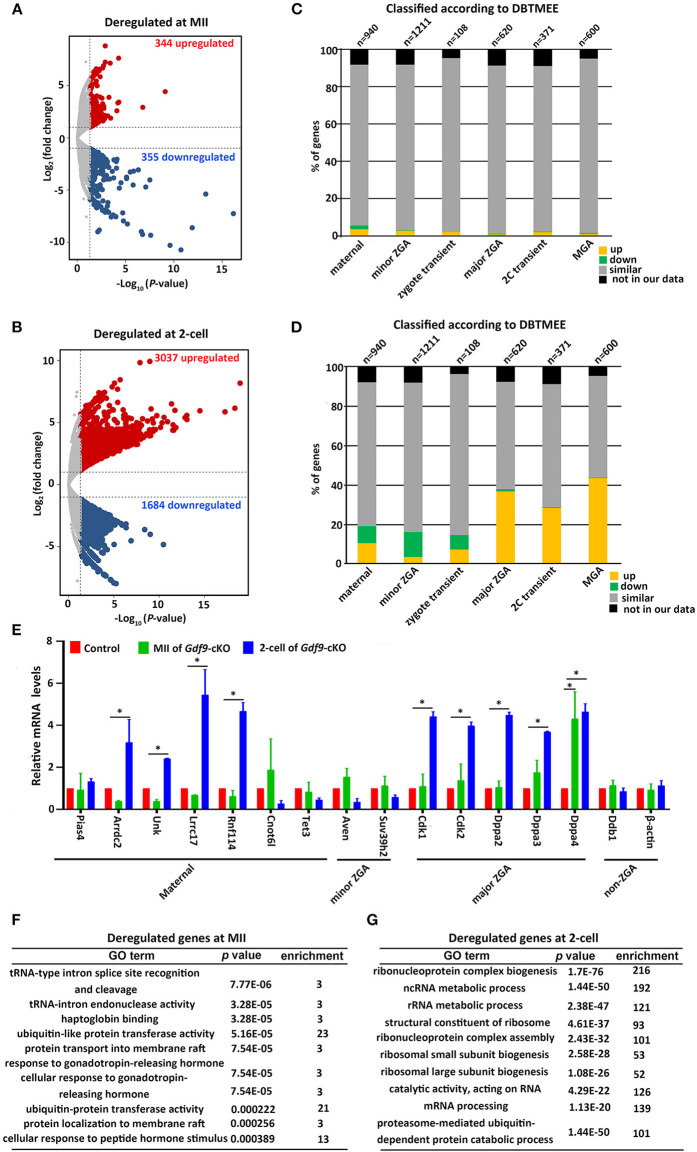
Abnormal ZGA upon absence of maternal UHRF1 revealed by transcriptome analysis. (A,B) Volcano plots showing the RNA-seq data obtained from (A) MII oocytes and (B) two-cell embryos of control and Gdf9-cKO mice. Red and dark blue dots indicate genes that were significantly upregulated and downregulated, respectively (fold change > 2, and FDR < 0.05) in Gdf9-cKO oocytes or embryos. (C,D) RNA-seq data from (C) MII oocytes or (D) two-cell embryos in comparison with the different categories of the gene catalog available at the Database of Transcriptome in Mouse Early Embryos (DBTMEE) generated the transcriptome analysis. The total number of genes in each class and found in this study is indicated on top of the graph. (E) RT-qPCR validates the expression of select upregulated and downregulated genes in MII oocytes and two-cell embryos from control and Gdf9-cKO mice. *p < 0.05 by Student's t test. (F,G) Top 10 representative GO terms (biological functions) enriched in Gdf9-cKO (F) MII oocytes and (G) two-cell embryos. p value indicates the significance of the enrichment.